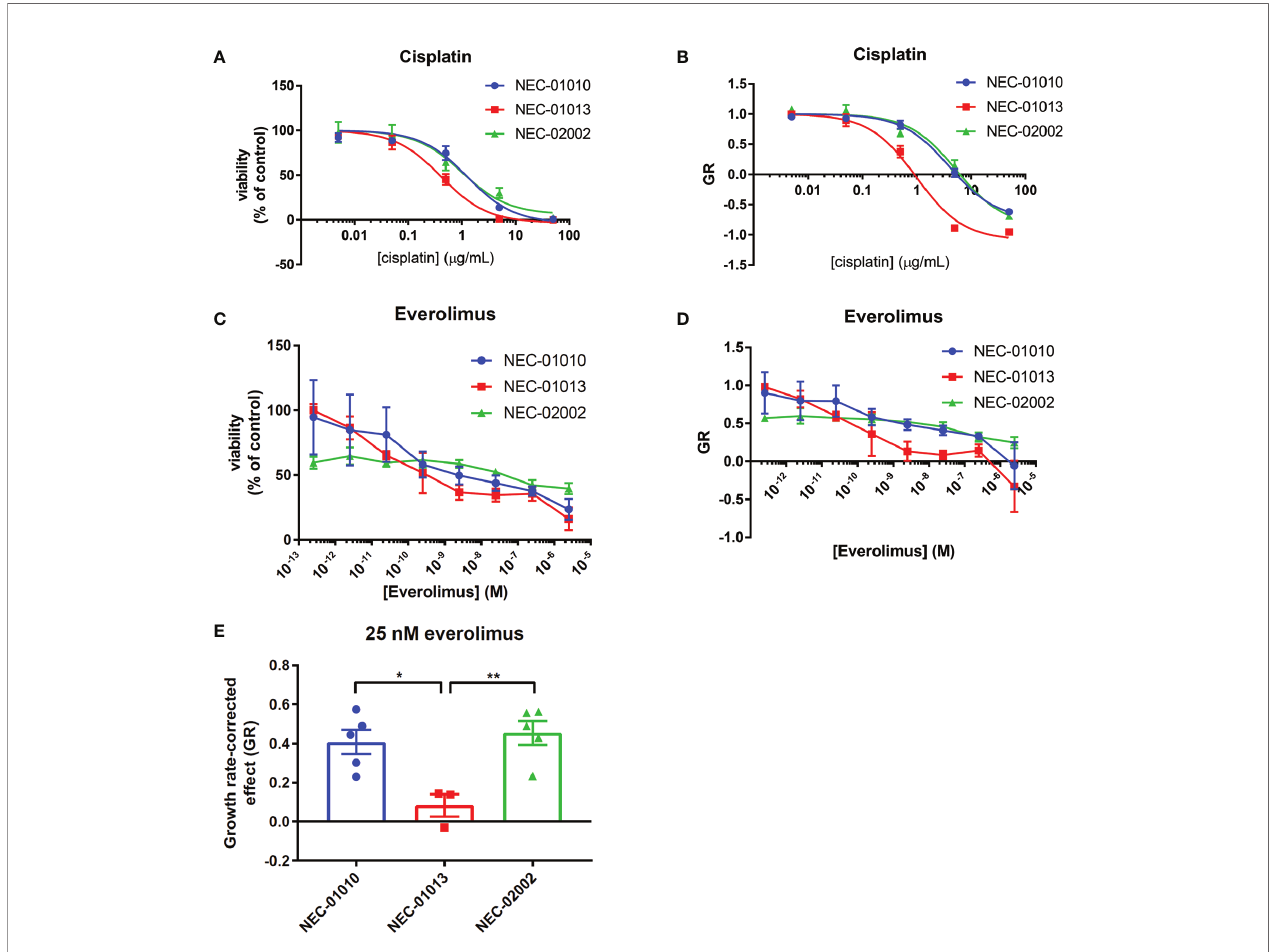
FIGURE 4 | Drug response of GEP-NEC organoids. (A, B) Viability (A) or growth-rate corrected viability (B) of cisplatin-treated GEP-NEC organoids. n = 3 – 4. NEC- 01010: passage (P) 6-14; NEC-01013: P10-19; NEC-02002: P6-16. (C, D) Viability (C) or growth-rate corrected viability (D) of everolimus-treated GEP-NEC organoids. n = 3 – 5. NEC-01010: P6-16; NEC-01013: P10-20; NEC-02002: P6-17. (E) GR at 25 nM everolimus (corresponding to C max ). n = 3 – 5. Error bars represent s.e.m. Student ’ s t test. *P < 0.05; **P <